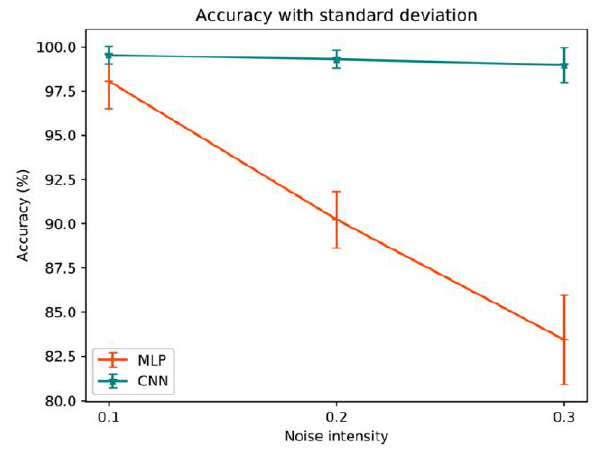
Figure 13. Comparison of the accuracy of convolutional neural network (CNN) and multilinear perceptron (MLP) models as a function of the introduced noise in the input data [95]. Reprinted with permission from Elsevier.